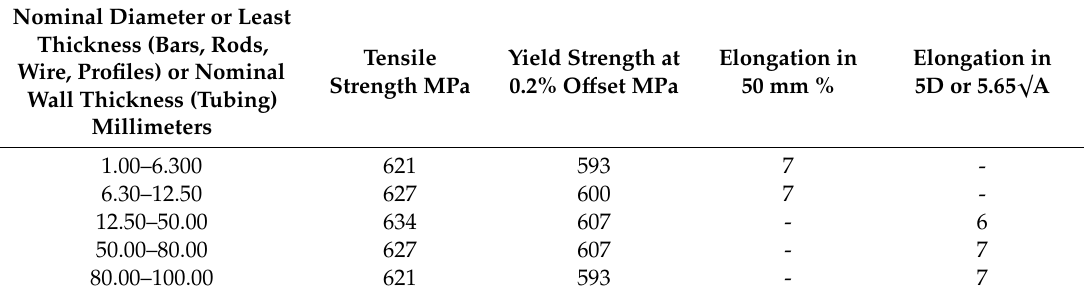
Table 3. Minimum tensile properties of Al7136.